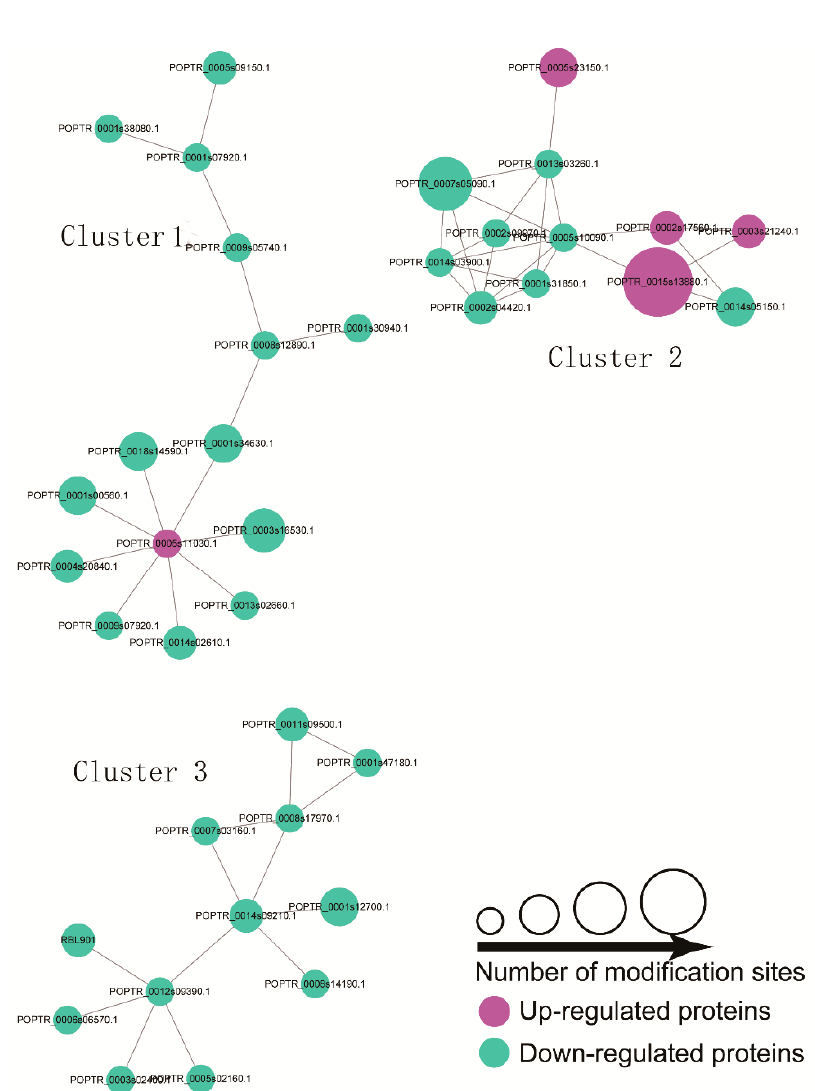
Figure 7. Interaction network of DPPs analyzed by Cytoscape sofware (version 3.0.1). The upregulated and downregulated proteins in the clusters are shown in cyan and green, respectively. Detailed information on node and proteins can be found in Tables S5 and S6.